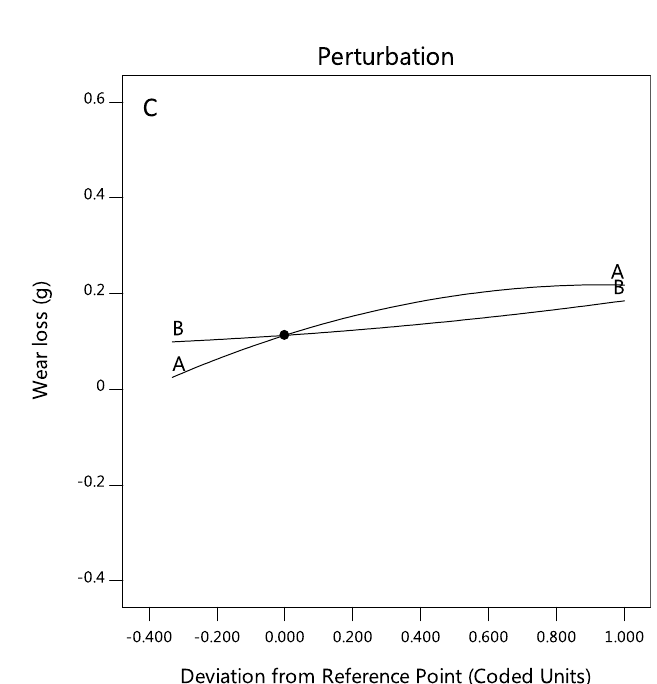
Figure 13. Perturbation plots for ( A ) wear rate, ( B ) specific wear rate, & ( C ) wear loss.